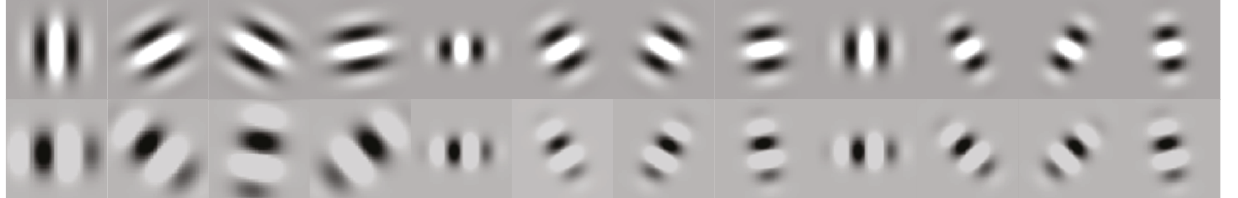
Figure 5: Examples of odd and even Gabor filters with di ff erent sizes and orientations. The first row is even filters and the second row is odd